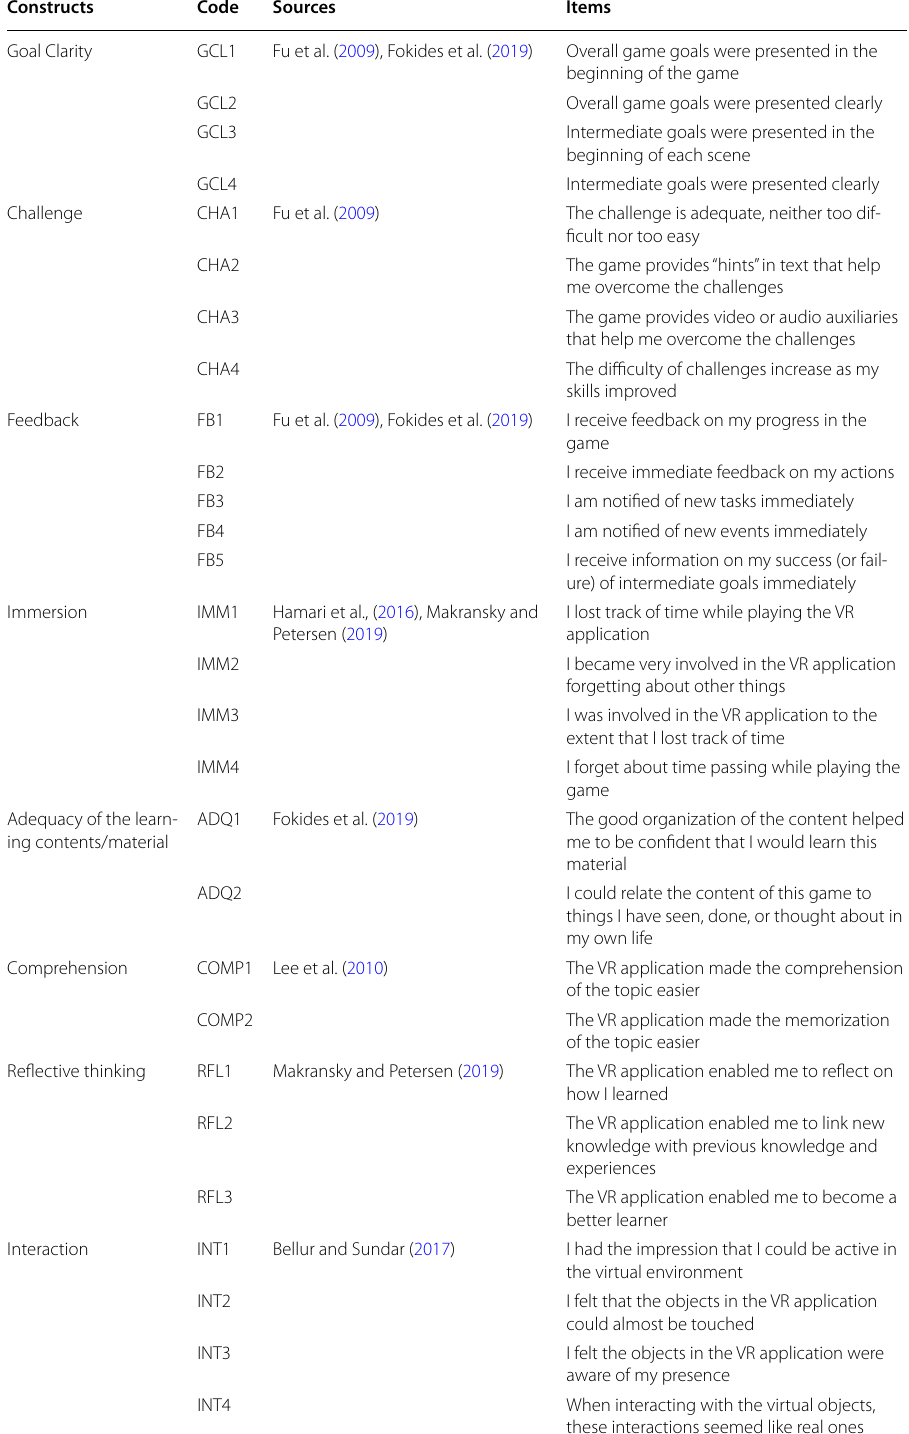
Table 7 Instruments used to collect large data on iThinkSmart App